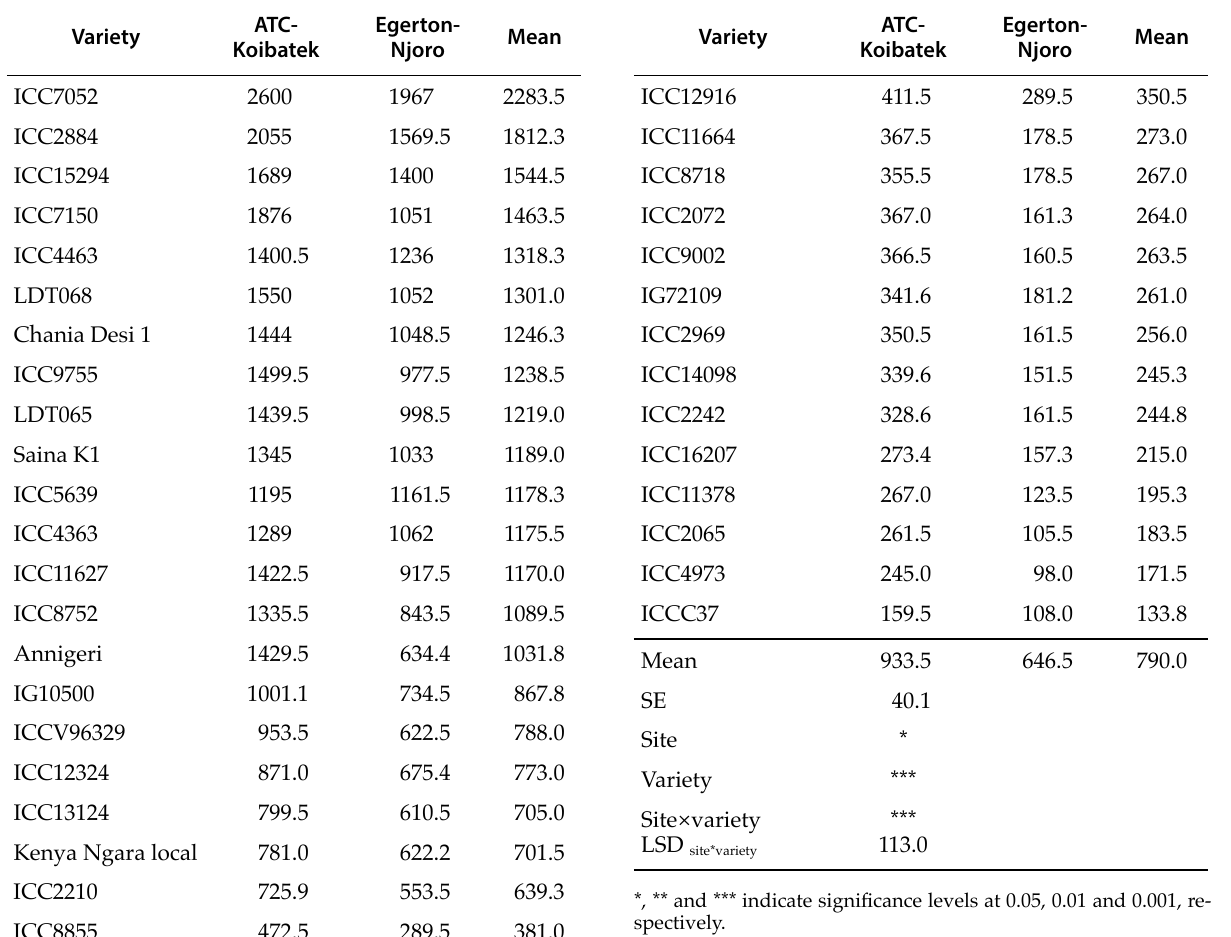
Table 2. Mean grain yield (Kg ha -1 ) for 36 test chickpea genotypes in ATC-Koibatek and Egerton-Njoro,